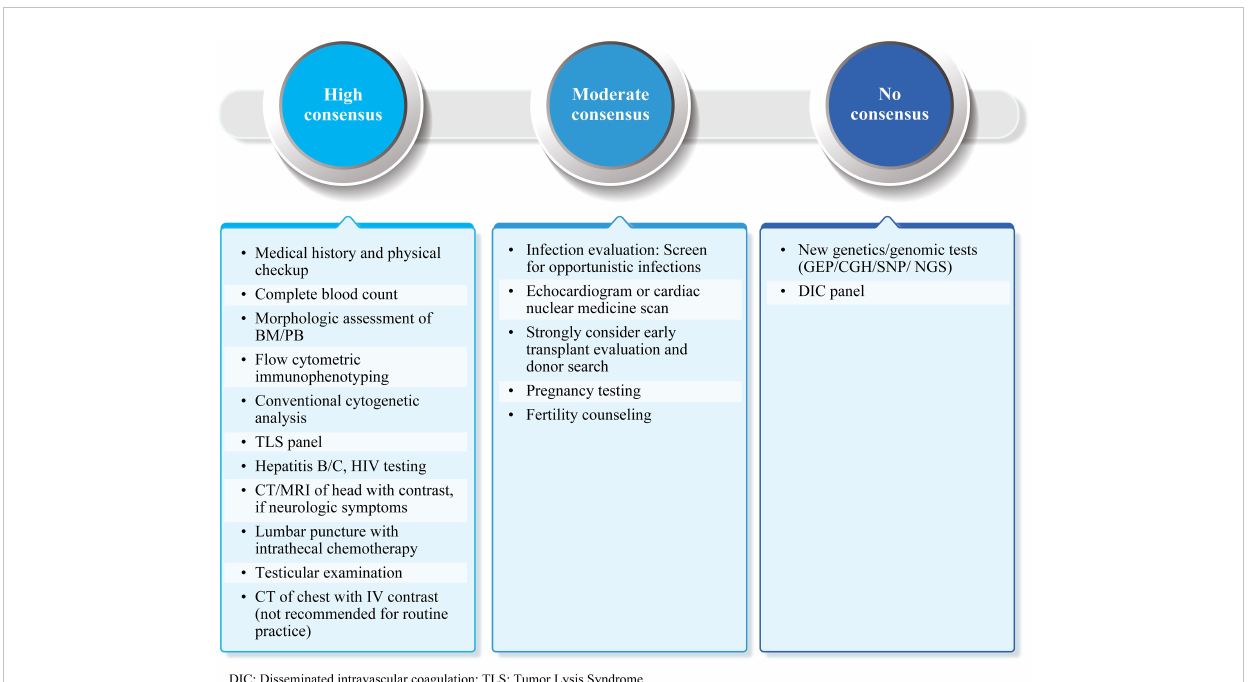
FIGURE 2 Initial diagnostic workup: Summary of expert consensus/recommendations. B-ALL, B-cell lineage acute lymphoblastic leukemia; BM, Bone marrow; PB, Peripheral blood; CT, Computed tomography; MRI, Magnetic resonance imaging; IV, Intravenous; NGS, Next-generation sequencing; CGH, Comparative genomic hybridization; SNP, Single-nucleotide polymorphism; GEP, Gene expression pro fi ling; TLS, Tumor lysis syndrome; DIC, Disseminated intravascular coagulation.